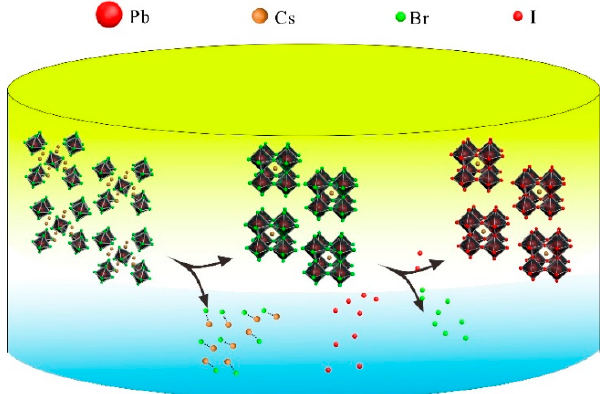
Figure 6. Illustration of the mechanism for the synthesis of CsPbX 3 perovskite NCs by interfacial anion exchange reaction.